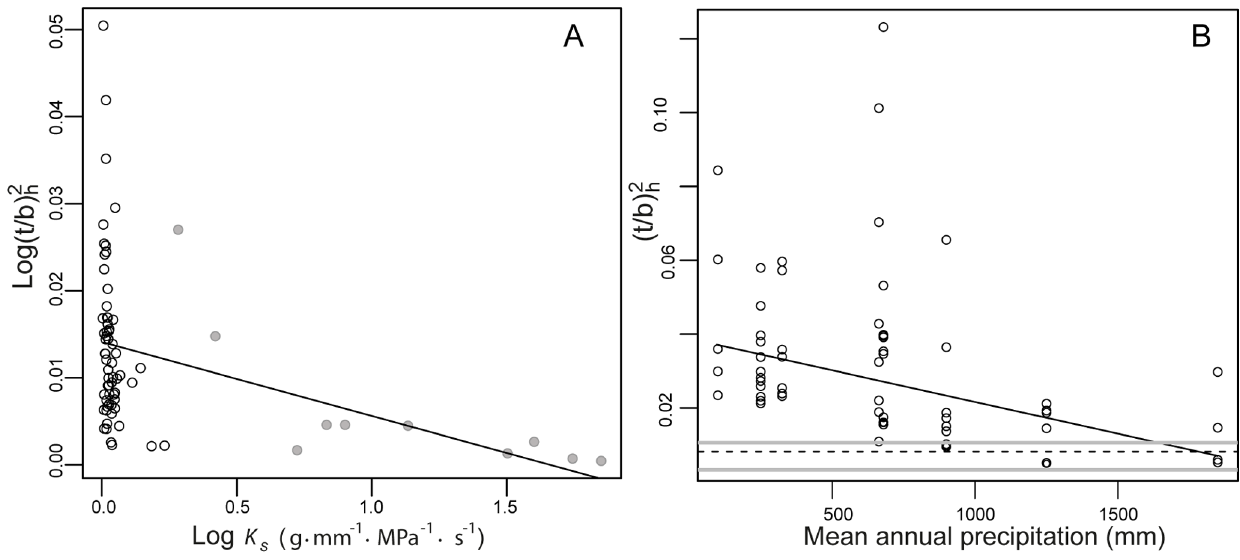
Figure 3. Implosion resistance as a function of a) potential conductivity, b) MAP. In figure 3a the Olmos formation xylotypes are in grey; black circles are the extant communities presented in Figure 2c. In figure 3b the horizontal lines show the median (dashed) and first and third quartiles (grey lines) of implosion resistance for the Olmos Formation, the circles are the species of all extant communities in Figure 2c. Regression line in 3a was fitted using simple linear regression on the log-transformed variables, while in 3b using weighed least square regression.